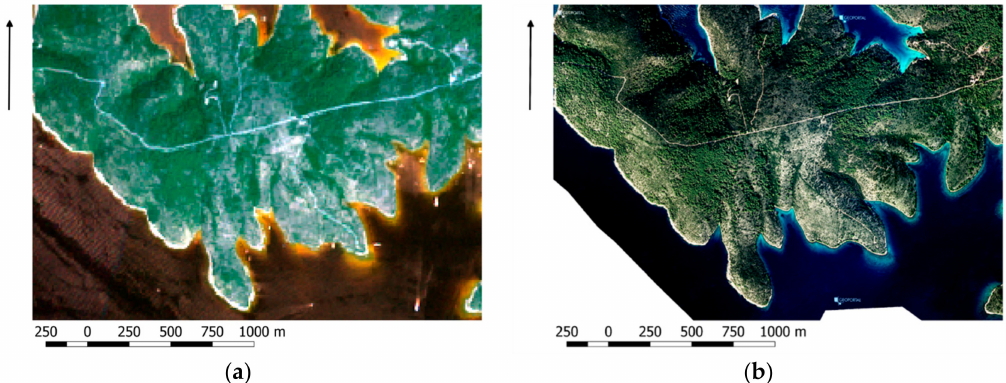
Figure 3. Case study area of Cape Kabal (source: Amazon S3 and SGA Geoportal): ( a ) Sentinel image from 1 August 2017; ( b ) Digital orthophoto image from 2016.